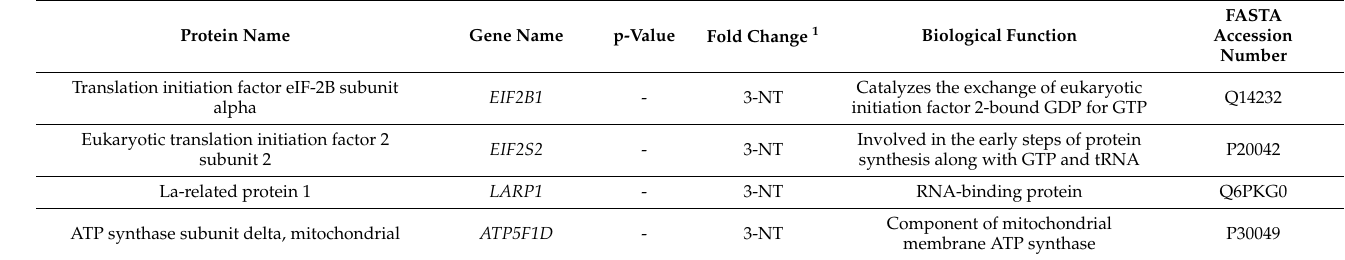
Table 2. Proteins from differentiated human enterocytes affected by the exposure to 200 µ